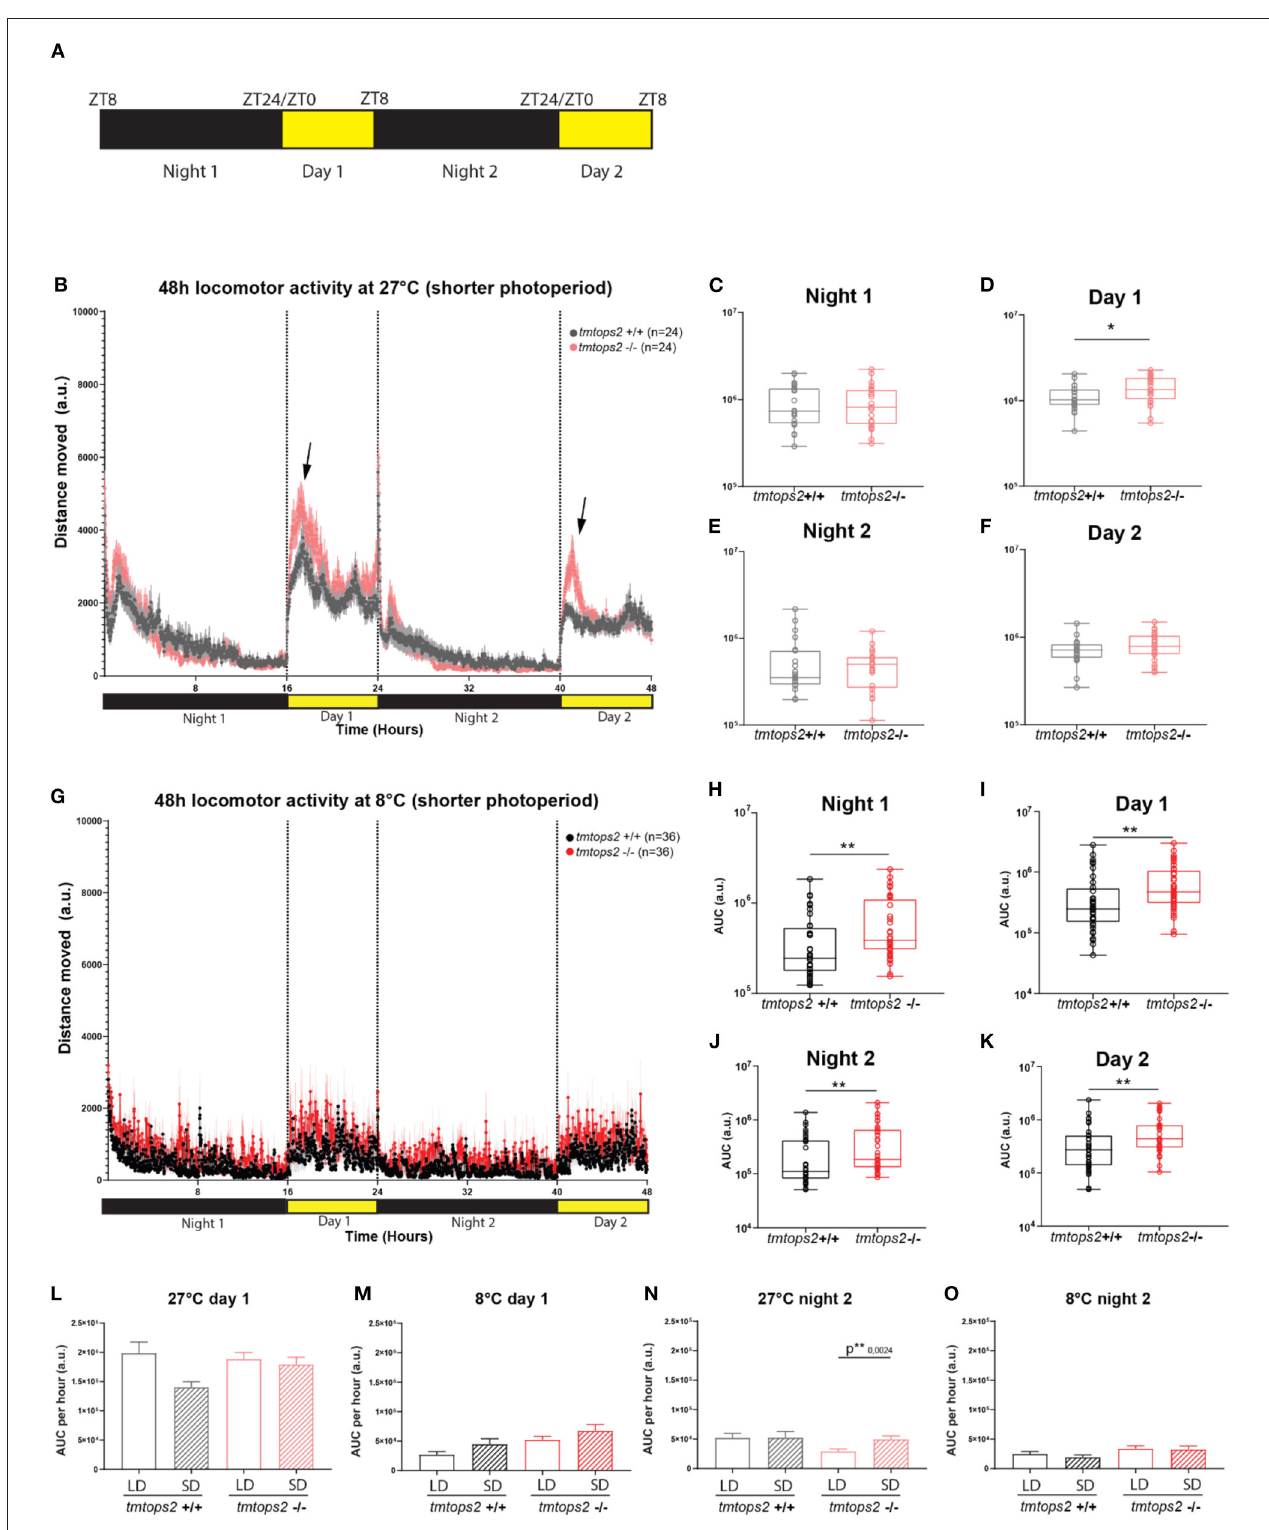
FIGURE 4 | Acute temperature changes exhibit stronger effects than acute photoperiod changes. Distance moved quantified at 27 and 8 ◦ C with a short photoperiod of 8L/16D. (A) Schematic representation of the experimental design within the behavioral setup: 8 hours light/ 16 hours dark (L/D) regime. (B) The average distance moved over the course of 48h at 27 ◦ C. Each point represents the mean ( ± SEM) distance moved for the preceding 1min. Yellow and black boxes along the x -axis